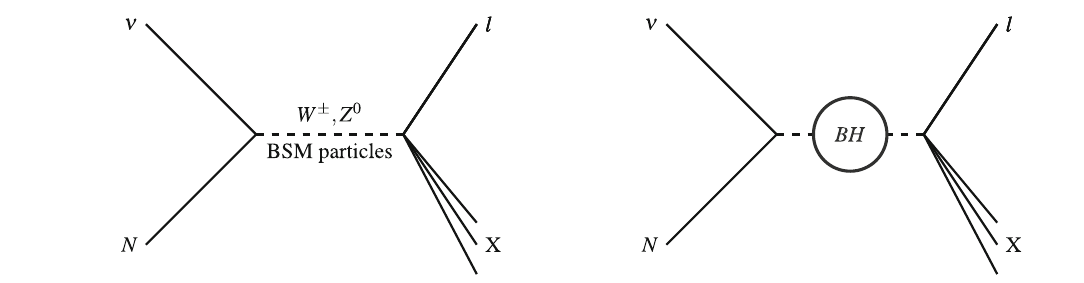
Fig. 1 Feynman diagrams for neutrino nucleon scattering process. Left: in absence of BH production ν N → lX . In SM the process is mediated by W ± or Z 0 , depending on CC or NC interaction, while in presence of NSI, the interaction is mediated by any beyond stan-